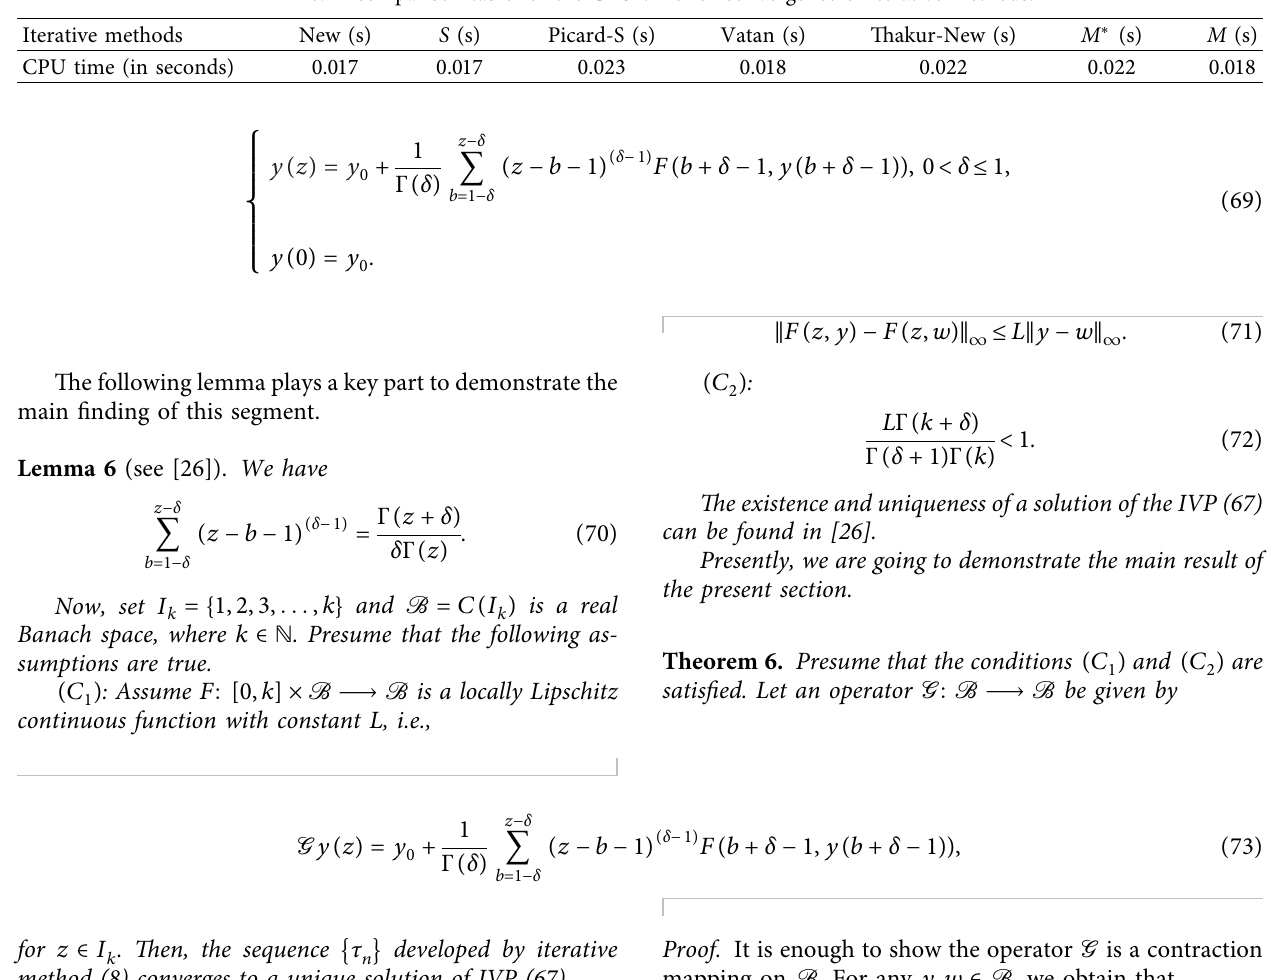
Table 6: A comparison table for the CPU time for convergence of iterative